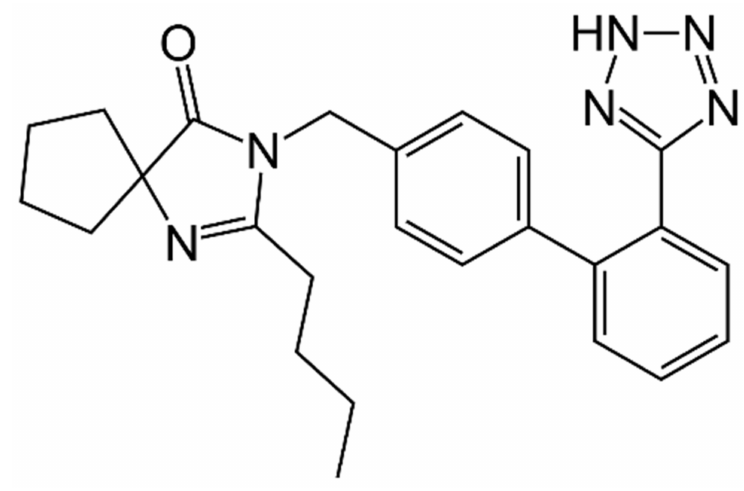
Figure 1. Molecular structure of